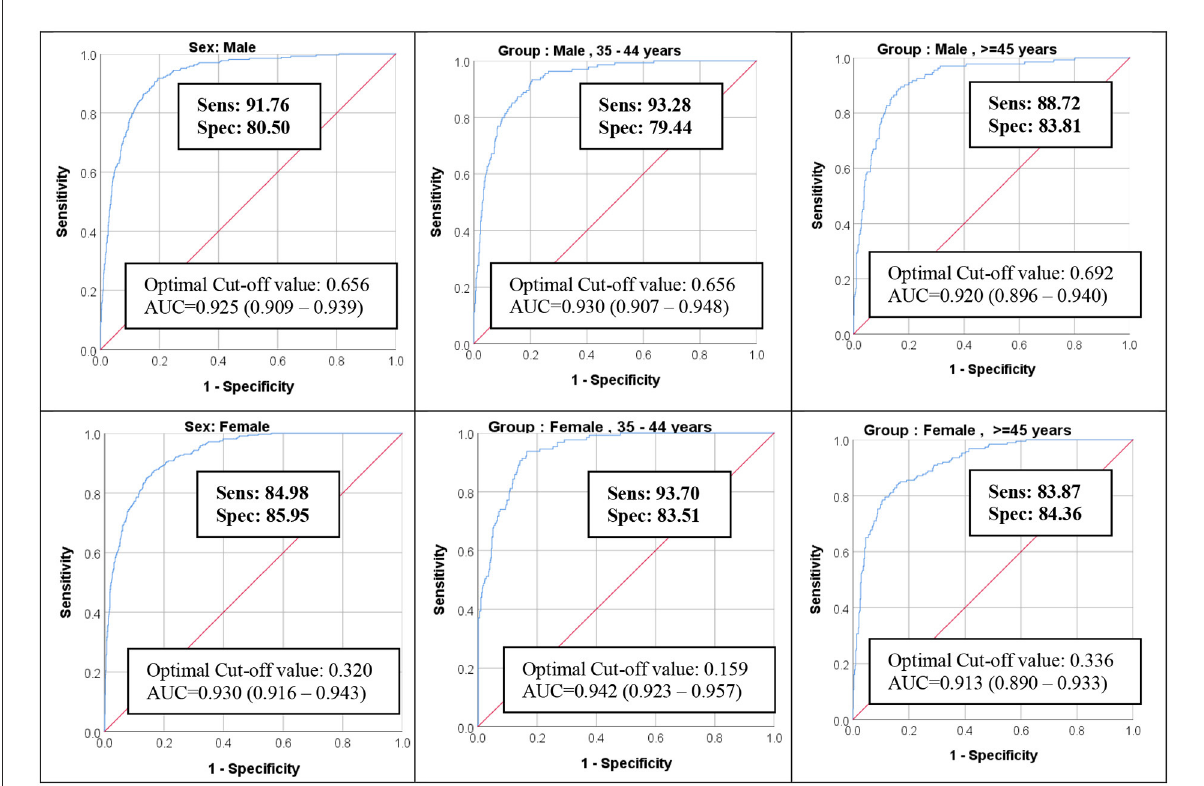
FIGURE1 ROC Curve of MetS severity Z-score for predicting MetS NCEP Criteria for the Iranian population. ROC, receiver operating characteristic; MetS, metabolic syndrome; AUC, area under the curve.